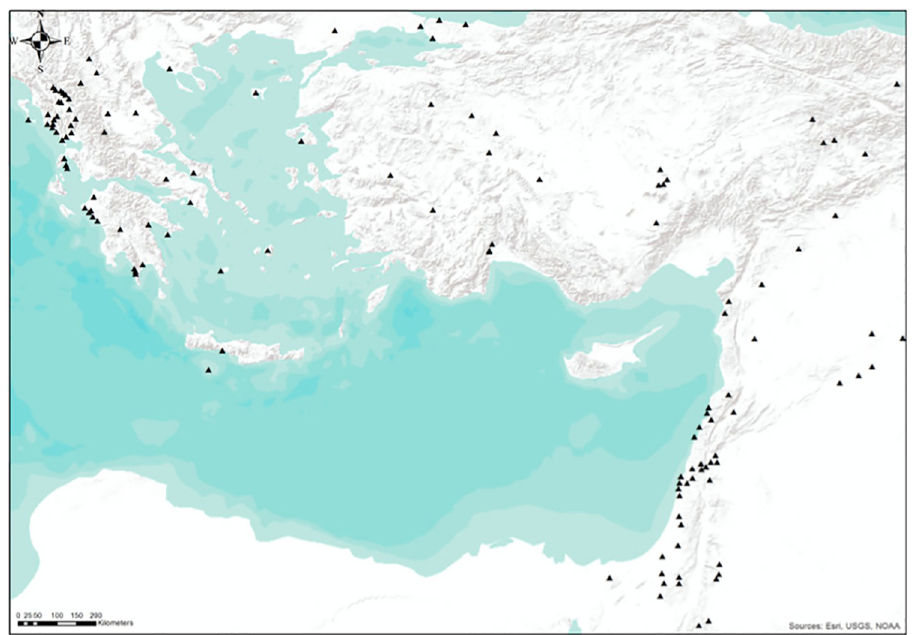
Fig 2. Eastern Mediterranean Pleistocene sites. Map showing Pleistocene archaeological sites in the circum-Cyprus Eastern Mediterranean region. A detailed list of the sites and references can be found in S1 Table. Original copyright with the